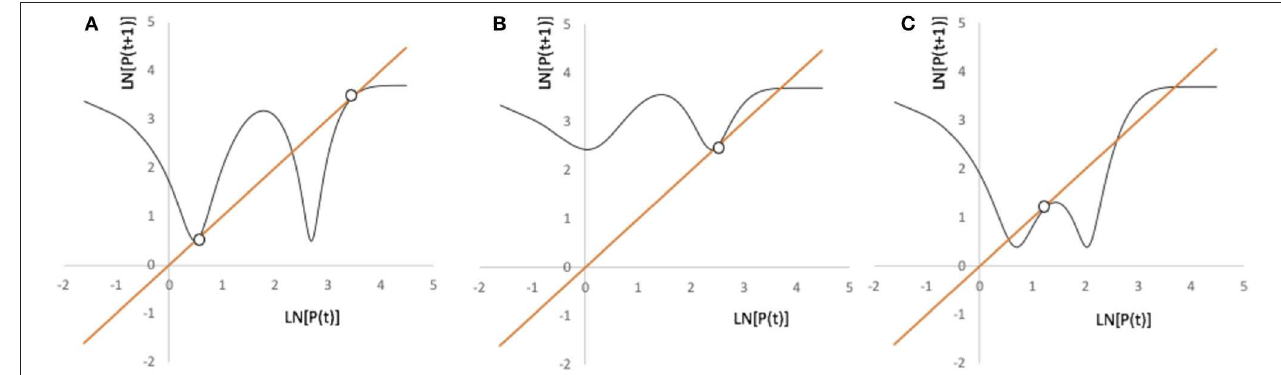
FIGURE 11 | Illustration of the four possible bifurcation points for the model in Equation (3). Parameters for all three panels are P max b 0.17, a 10.5, h 0.0426. (B) b = = =